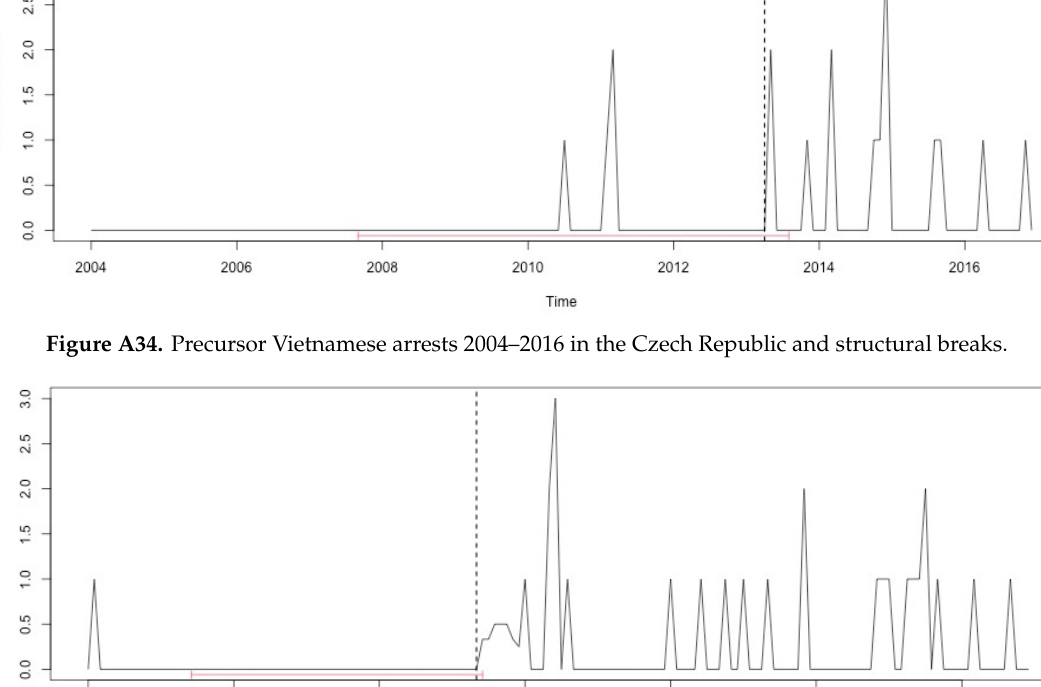
Figure A35. Precursor neighboring countries arrests 2004–2016 in the Czech Republic and structural breaks.